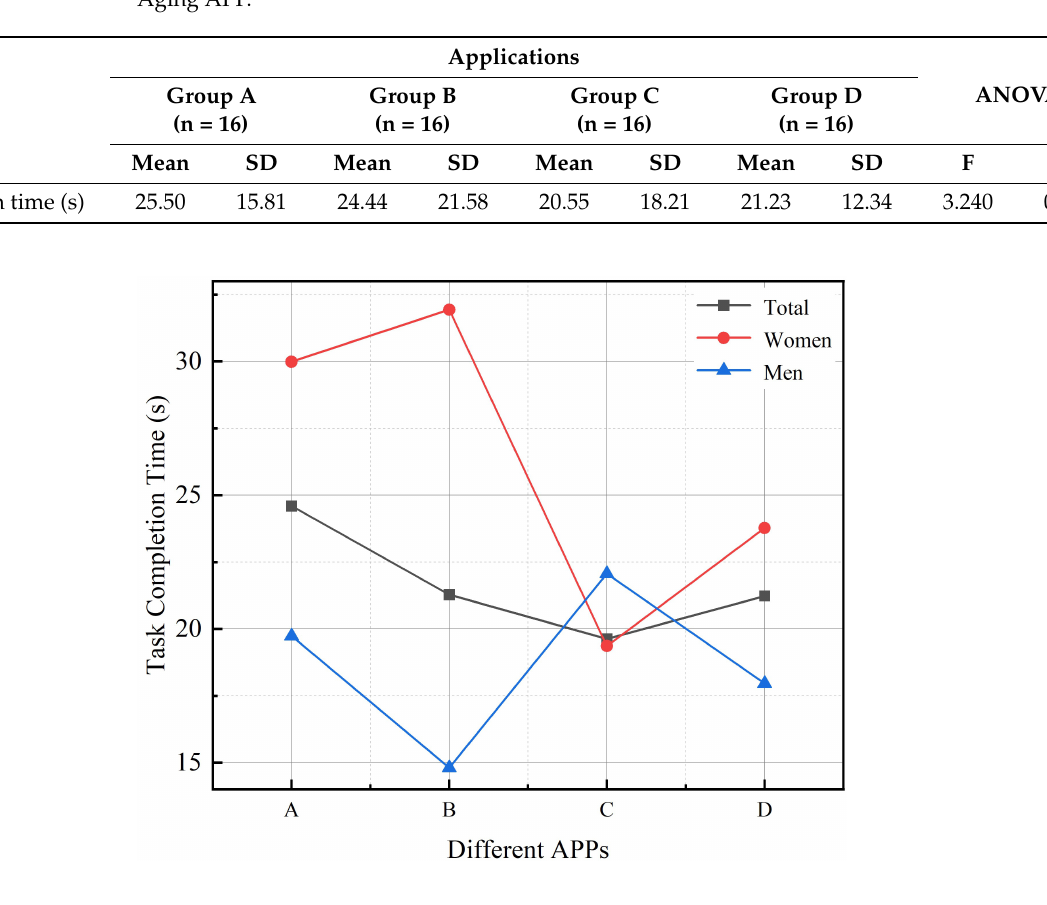
Table 2. ANOVA of participants’ task completion time for different Apps: A refers to C-life Senior Care APP; B refers to Senior Living APP; C refers to Senior Care Manager APP; D refers to Smart Aging APP.